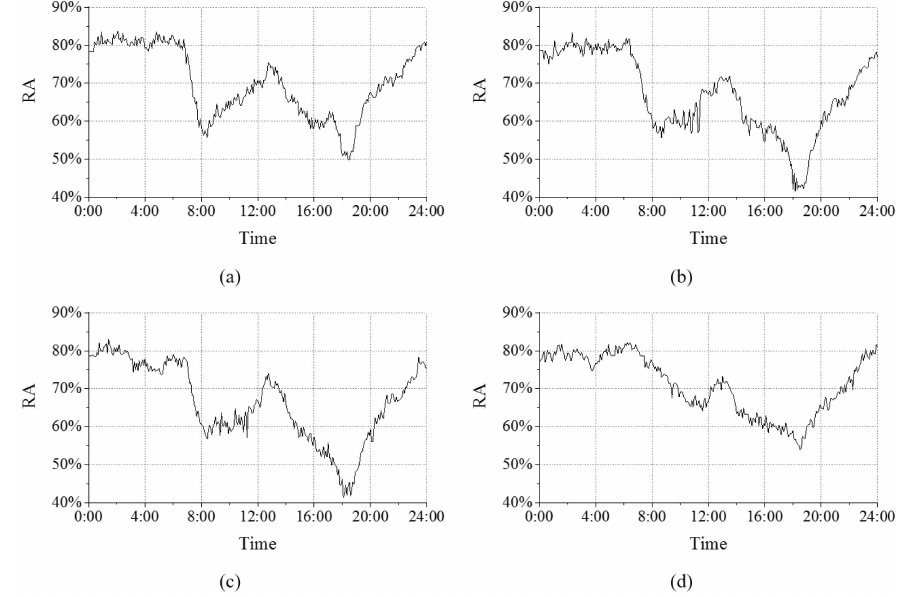
Figure 3. Traffic conditions of Shenzhen on ( a ) 19; ( b ) 21; ( c ) 23; and ( d ) 25 October 2015. These four days are Monday, Wednesday, Friday, and Sunday, respectively. The smaller the RA, the more congested the traffic